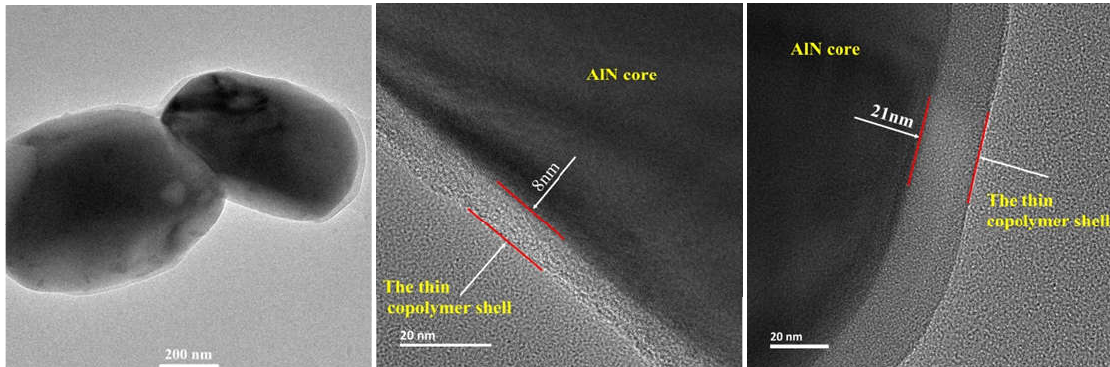
Figure 9. TEM diagram of modified powder.